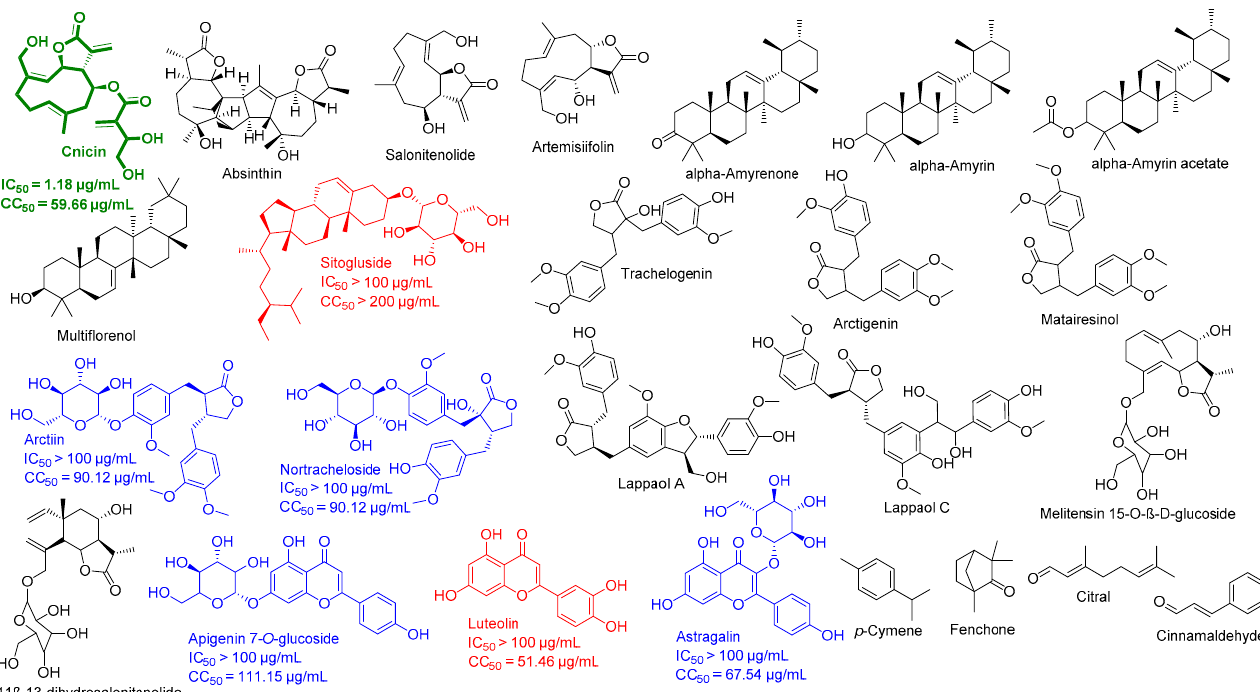
Figure 3. The chemical constituents in the CBE. Blue color indicates the compounds predicted to be active against SARS CoV-2, and green color (i.e., cnicin) indicates the active antiviral hit. Red-colored structures are compounds that did not target any protein in the in silico analysis, and only colored compounds were tested against SARS CoV-2 in vitro based on the results of the primary in silico analysis.